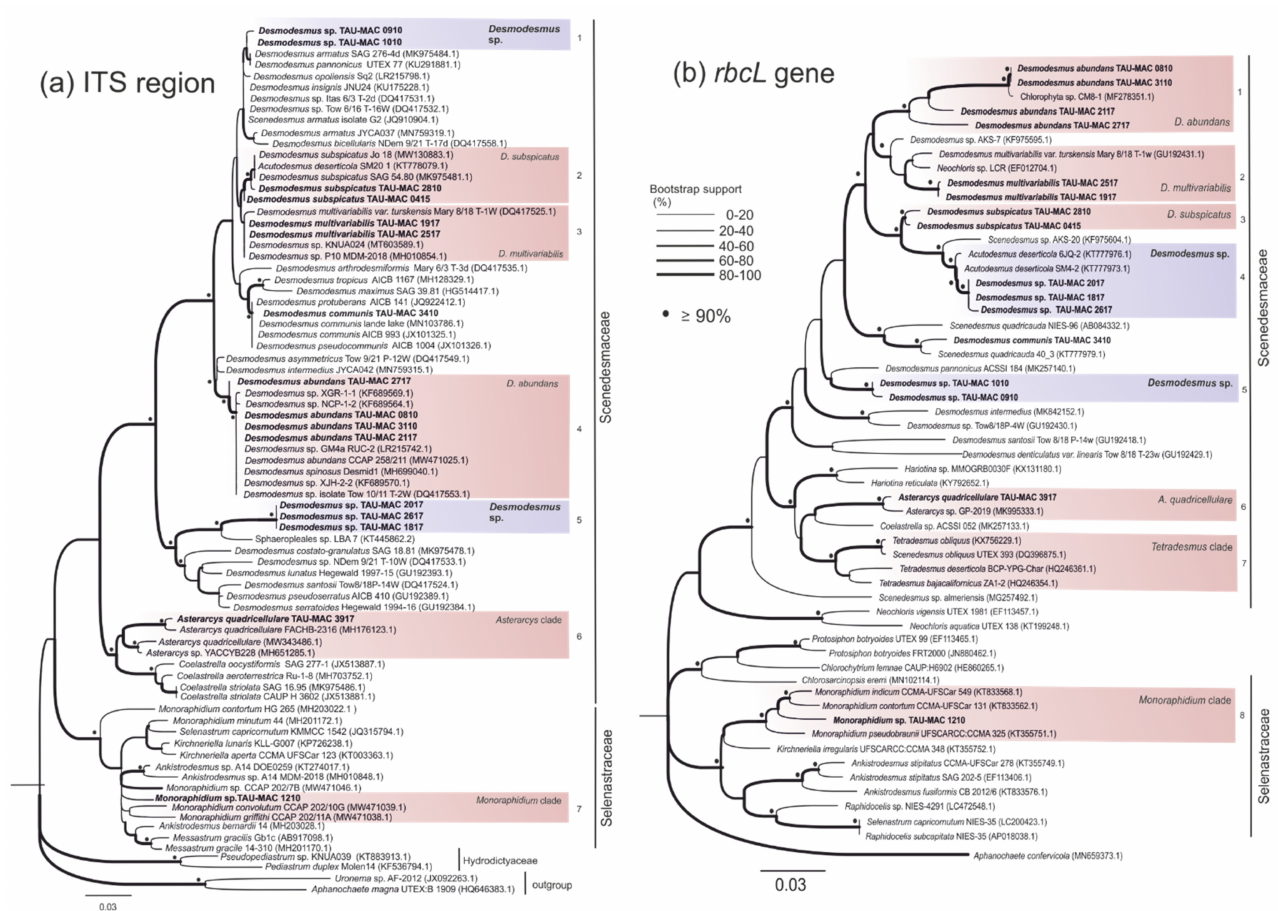
Figure 2. Phylogenetic relationships of the Sphaeropleales TAU-MAC strains based on ITS region (c. 500 bp) and rbcL gene (c. 1050 bp) genes including Scenedesmaceae and Selenastraceae families. Line thickness at branches (see explanation in figure) represents bootstrap support values (bootstrap support for ML and MP analysis). The numbers in parentheses are GenBank accession